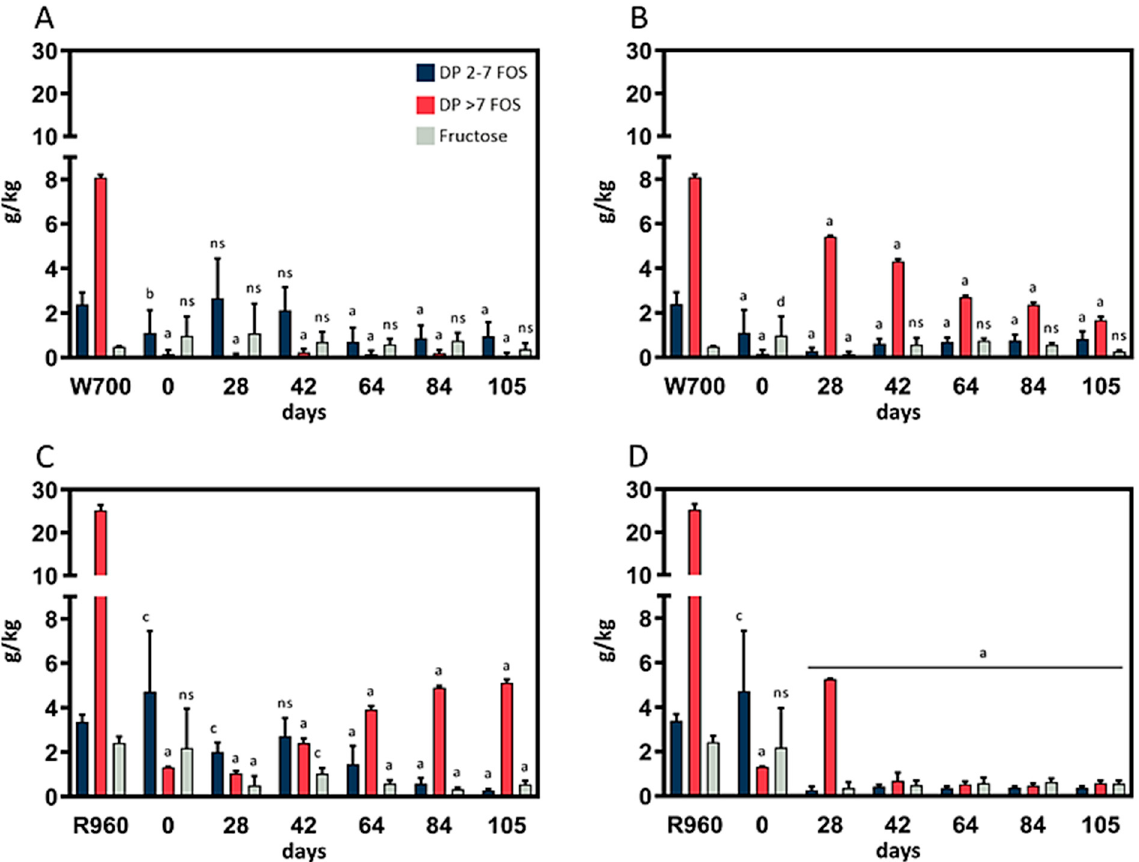
Figure 1. Fructose, DP 2–7 FOS, and DP >7 FOS content of sourdough (35 g water; 35 g flour). p < 0.05 ( c ), p < 0.01 (b), and p < 0.0001 (a) indicate significant differences from the control. ( A ) Wheat sourdough; 4 °C; W700. ( B ) Wheat sourdough; 10 °C; W700. ( C ) Rye sourdough; 4 °C; R960. ( D ) Rye sourdough; 10 °C; R960.